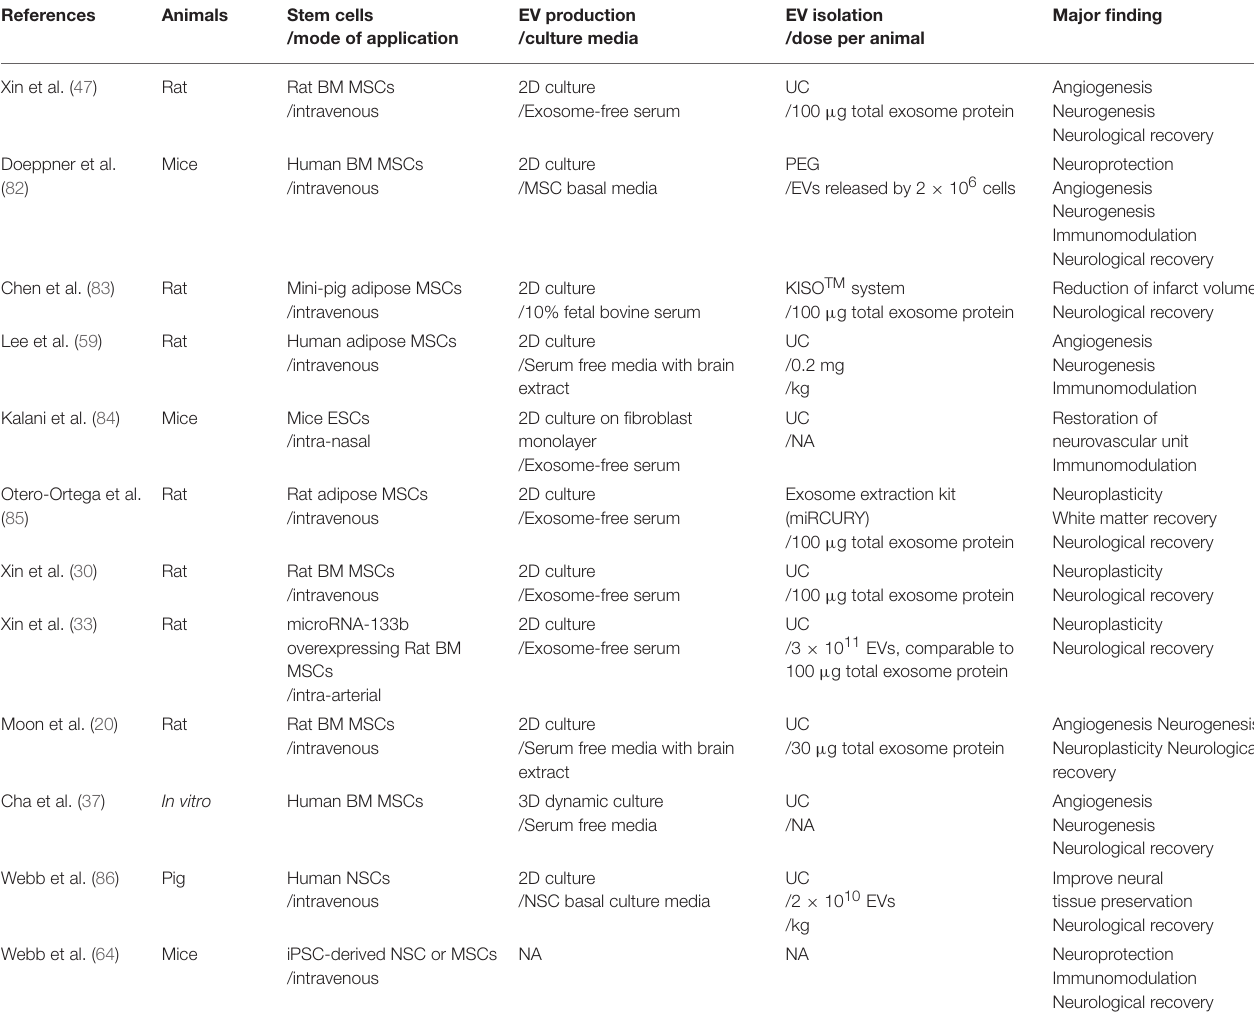
TABLE 2 | Various applications of stem cell-derived EV in